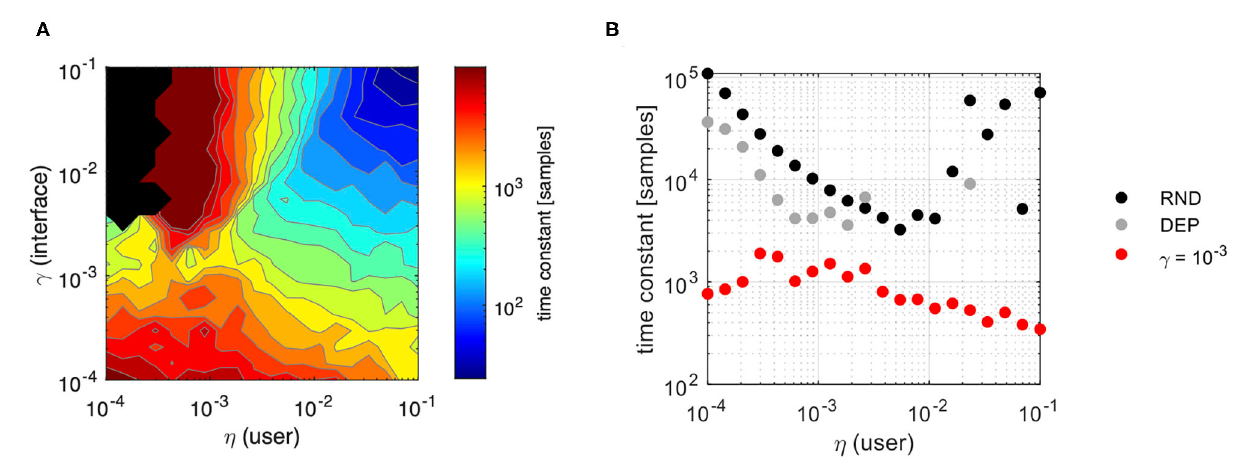
FIGURE 8 | Convergence analysis. Estimated convergence rate from exponential fitting of Subspace Angle values over iterations for different combinations of user and interface rates of adaptation; (A) estimated time constant to convergence for Subspace Angle during co-adaptation. Only values for which the goodness of fit R 2 ≥ 0.40 have been included (black regions correspond to missing data); (B) comparison between the estimated time constants for different degrees of user learning in the case of a static interface and independent samples (RND—black line) or dependent samples (DEP—gray line) and after interface coadaptation with γ = 10 − 3 (red line). Again, only values for which R 2 ≥ 0.40 have been